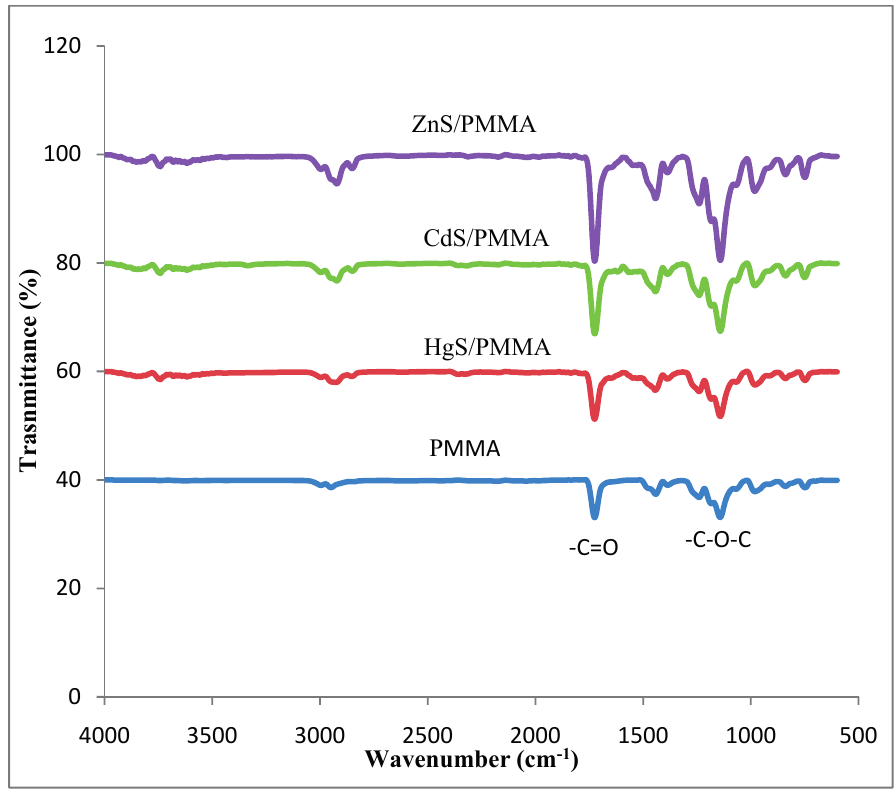
Figure 1. FTIR spectra of PMMA and the metal sulfide